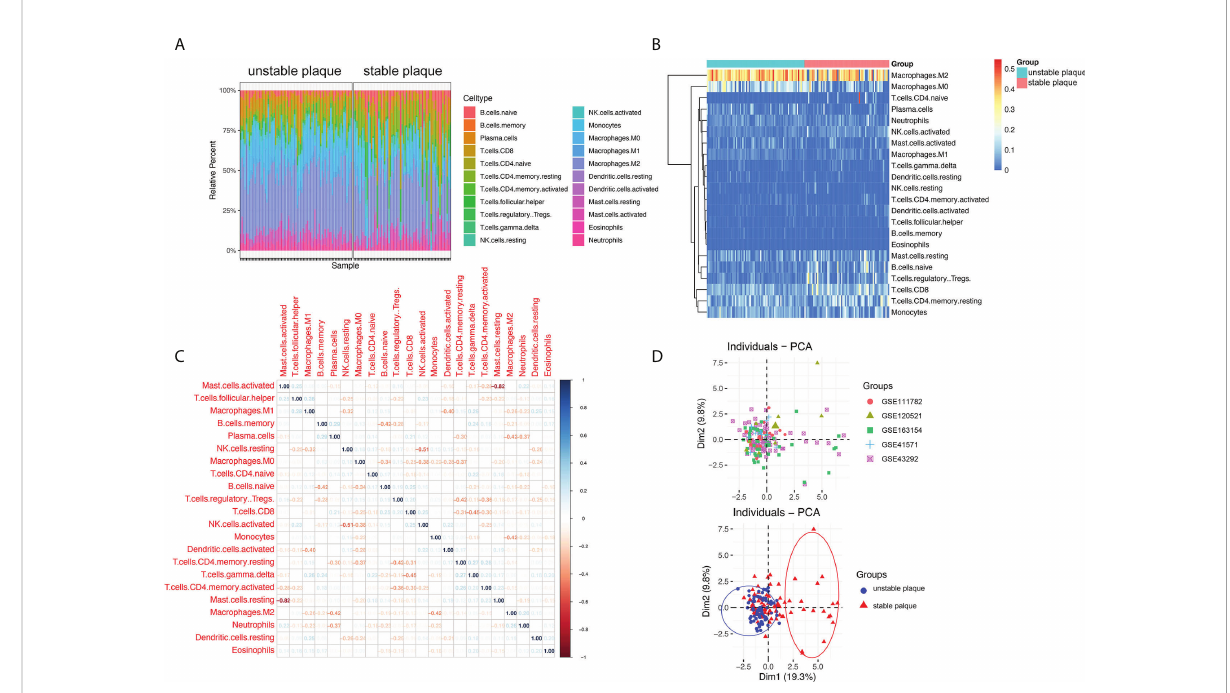
FIGURE 1 Immune cell in fi ltration in unstable and stable plaques. (A) Bar plot showing the composition of 22 types of immune cells across samples. (B) Heatmap of the composition of 22 types of immune cells across samples, colored by normalized relative abundance. (C) Correlation heatmap of 22 types immune cells in ruptured plaque samples. Blue indicates positive correlation, and red indicates negative correlation. (D) Principal component analysis plot of immune cells in fi ltration, colored by dataset (upper) and plaque stability